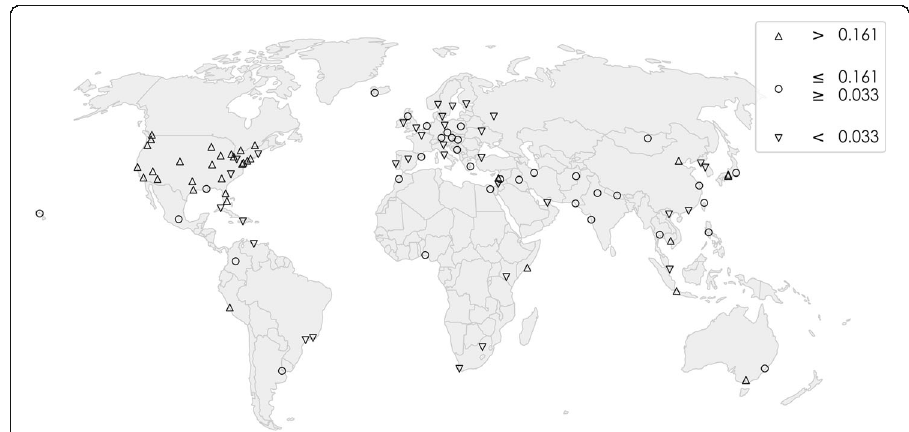
Fig. 2 Map of study sites in terciles of orientation-order,